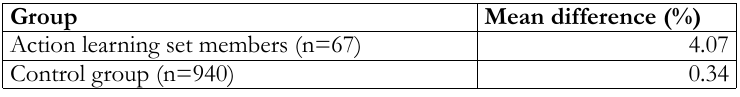
Table 4. Difference between thesis and course weighted average